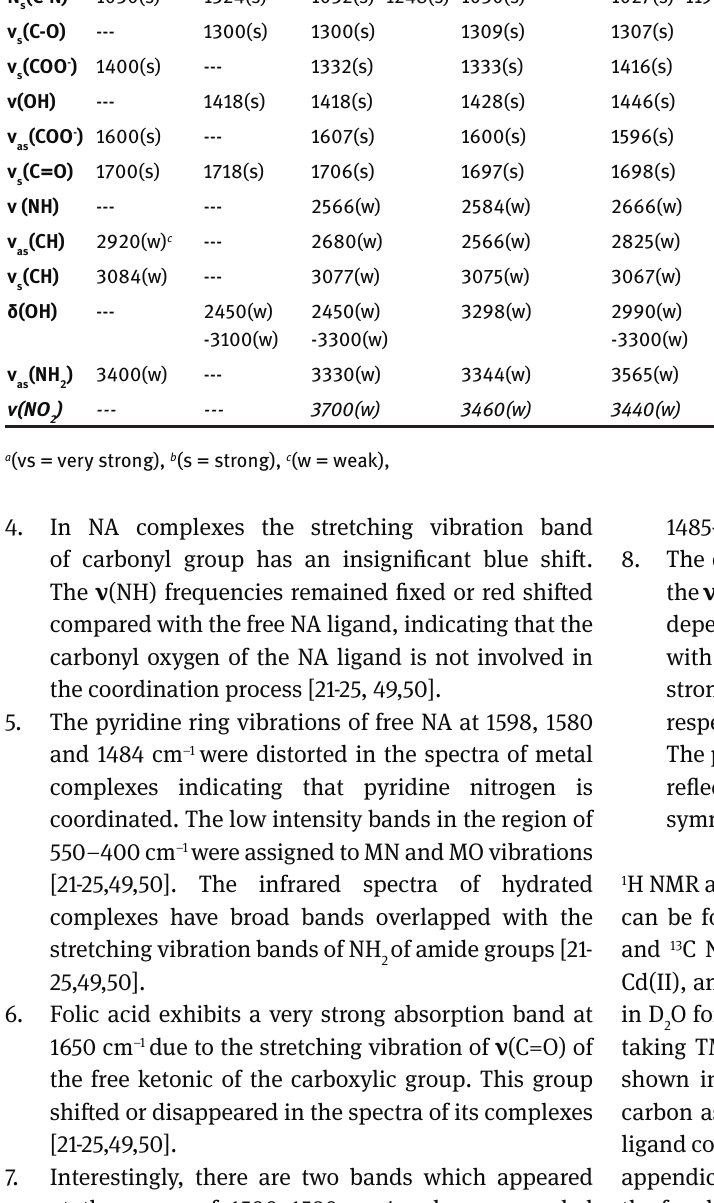
symmetric ( ν ) stretching vibrations [21-27,49-61]. s